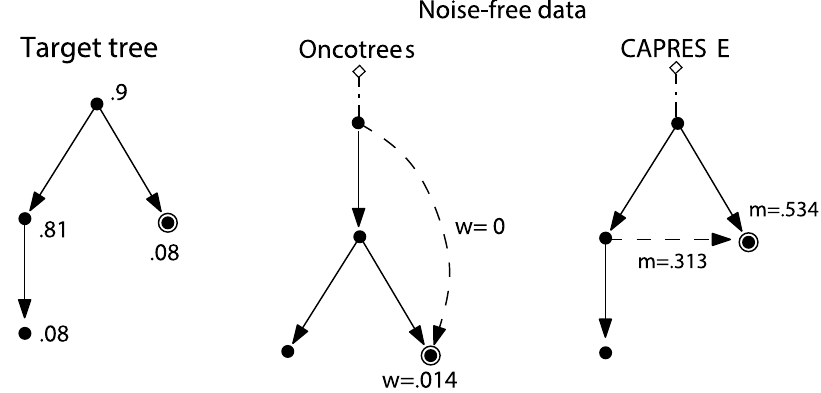
Figure 5. Example of reconstructed trees. Example of reconstruction from a dataset with 100 samples generated by the left tree (the theoretical probabilities are shown, i.e., the doubly-circled event appears in a sample with probability.08), with n ~ 0 . In the sampled dataset oncotrees mislead the cause of the doubly-circled mutation ( w ~ 0 for the true edge and w ~ 0 : 014 for the wrong one). CAPRESE infers the correct cause (the values of the estimator m with l ~ 1 = 2 are shown, similar results are obtained for l ? 1 ).